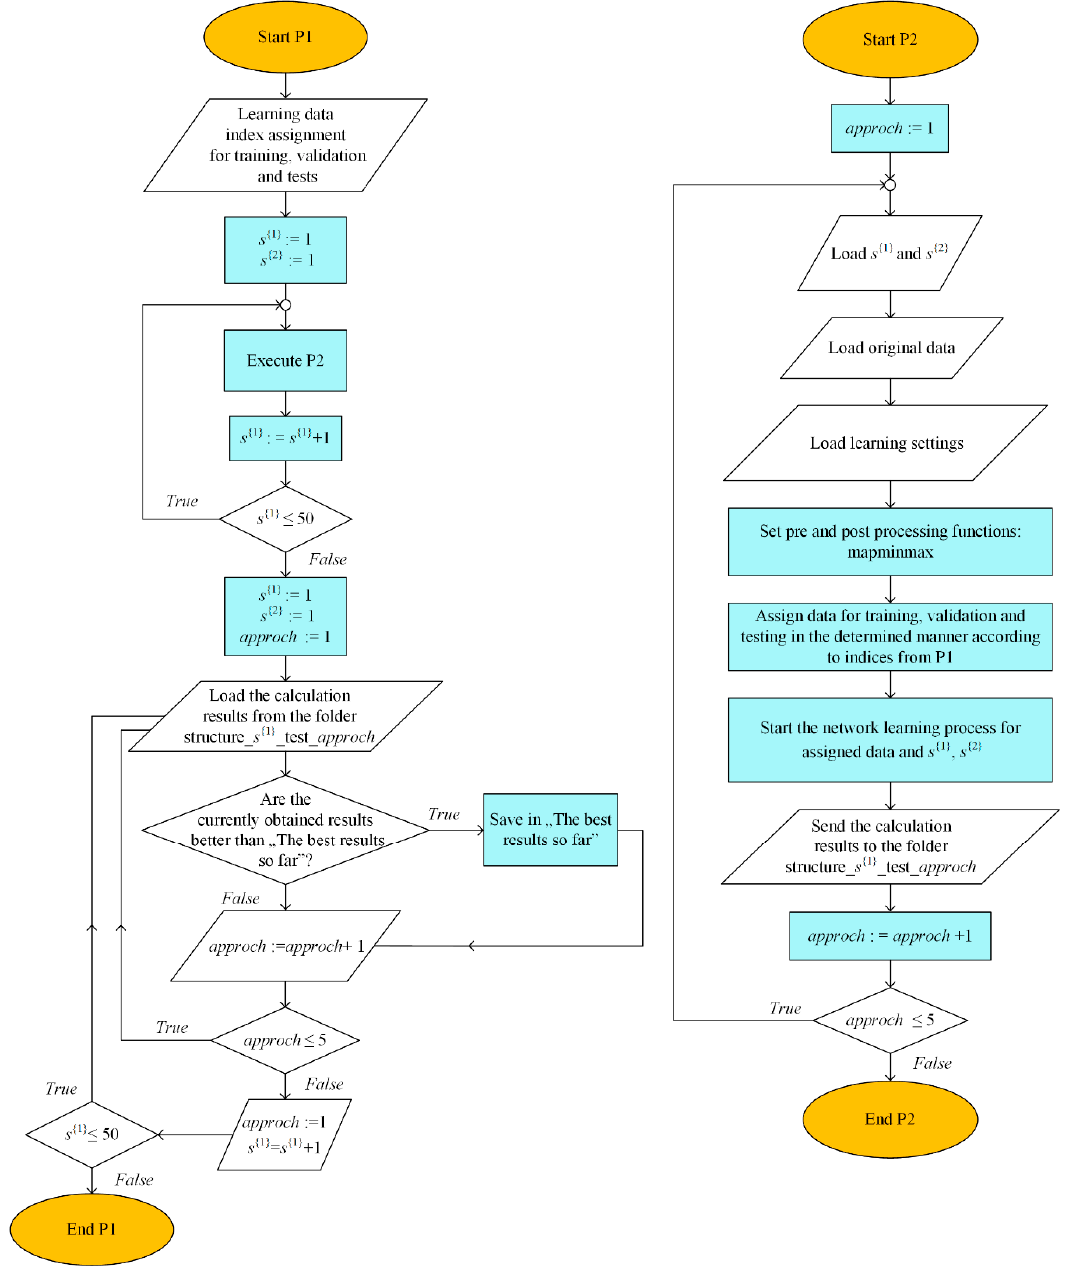
Figure 2. The algorithm for identification of the best possible dimension of the matrix of the model describing the examined physical phenomenon: P1 – the parent procedure; P2 – the nested procedure. The criterion for the choice of the ANN was selected as the minimum value of the maximum absolute value of the relative error [44,45] calculated for a given approach. An additional condition about resilience when changing initial weight and bias for neurons was needed to ensure repeatability of results in the tested problem [46–49].